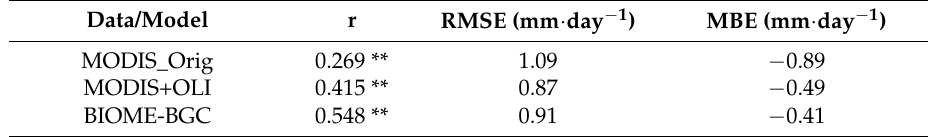
Table 1. Accuracy statistics of the daily olive transpiration estimates obtained applying the NDVI-Cws method with different NDVI datasets and BIOME-BGC (see text for details) (** = highly significant correlation, p <